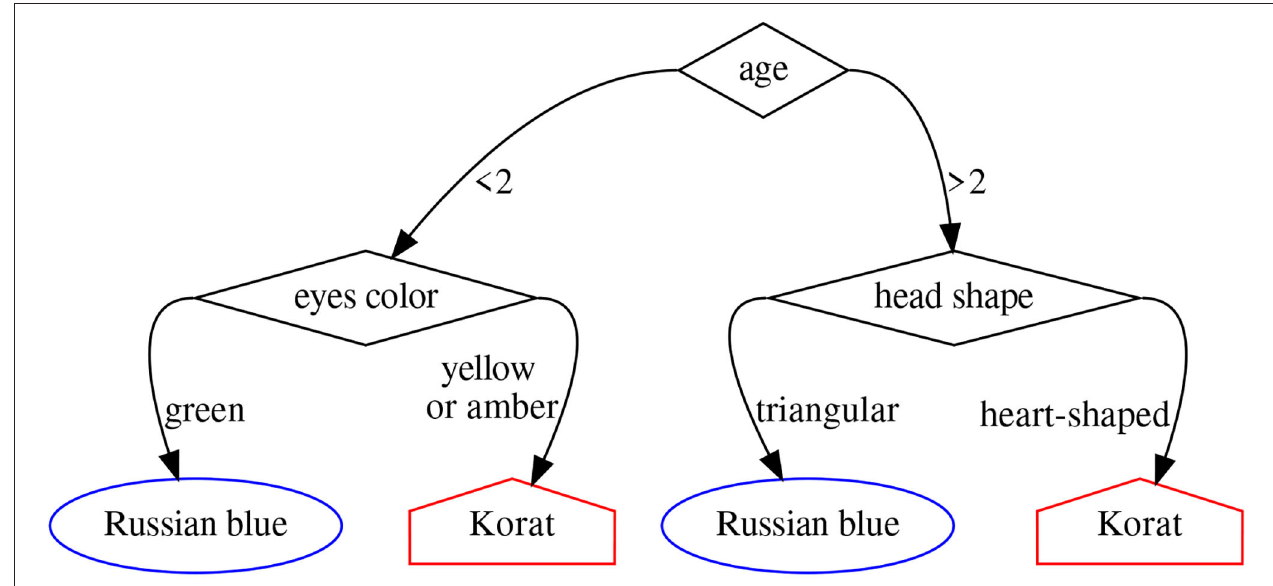
FIGURE 3 | Decision tree to determine whether a cat belongs to the Russian blue or the Korat breed.